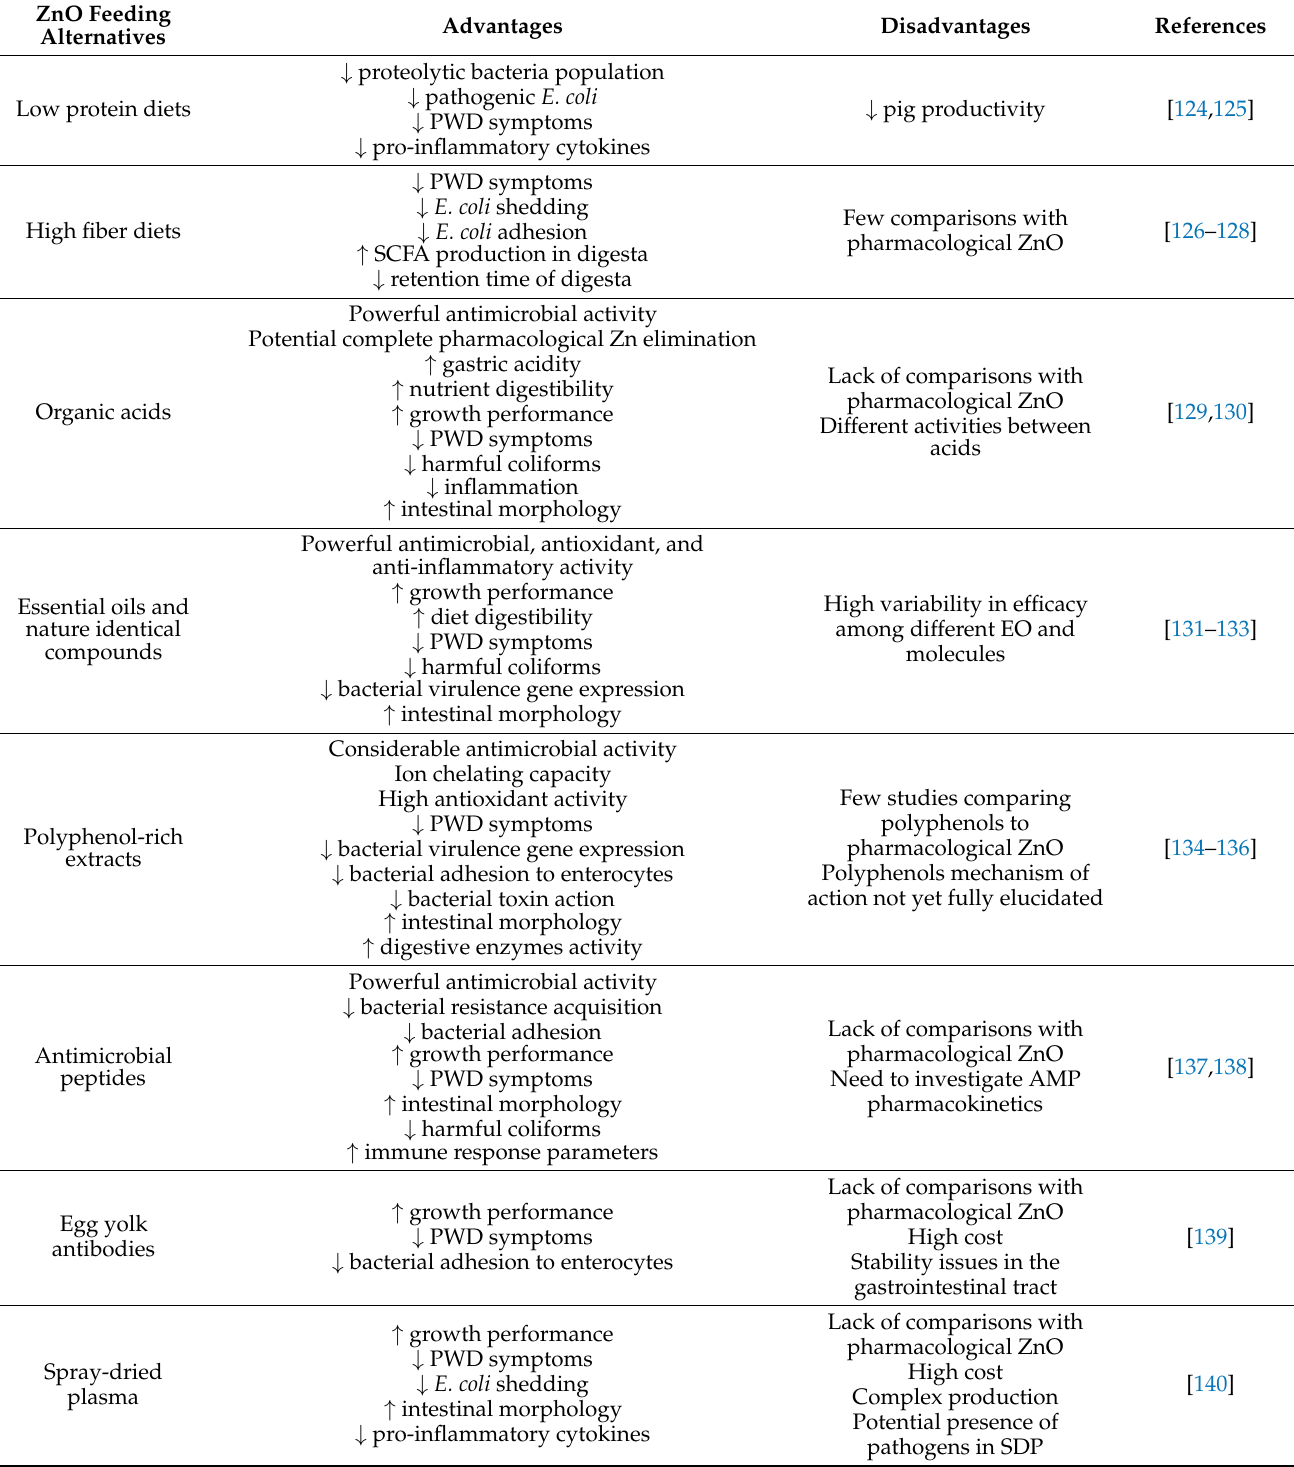
Table 1. Advantages and disadvantages of the main ZnO feeding alternatives for managing post-weaning diarrhea (PWD) and Escherichia coli F4 (K88) infections in weanling piglets. For each parameter, the up arrow “ ↑ ” means an increase, while the down arrow “ ↓ ” identifies a